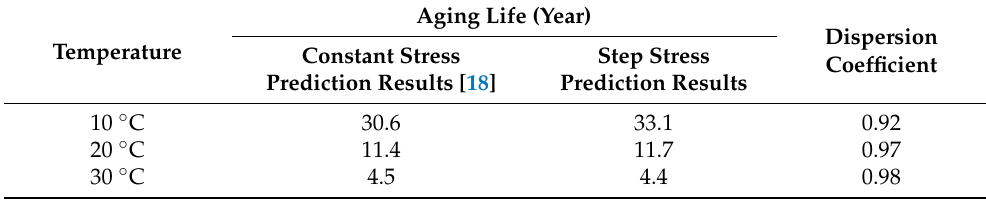
Table 4. Comparison of life prediction results between traditional and improved Arrhenius